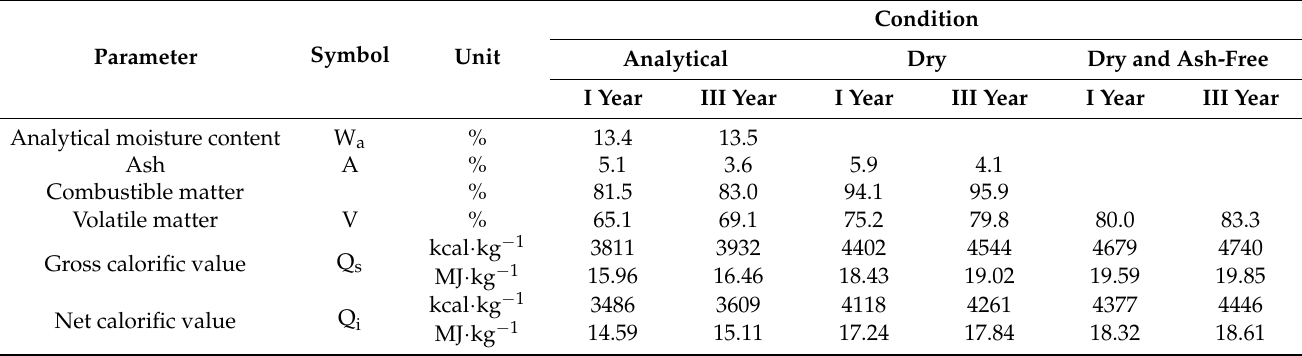
Table 15. Energetic parameters of cordgrass biomass